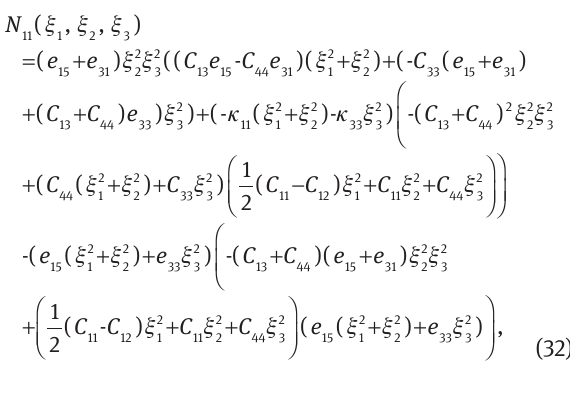
Figure 9 Variations of the total strain component ε component σ along the x -axis corresponding to a single QD and 33 3 two interacting